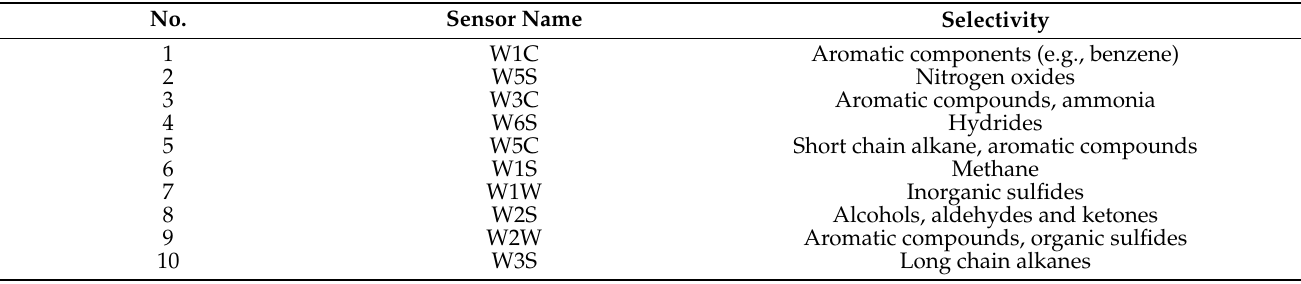
Table 1. Selectivity of electronic nose